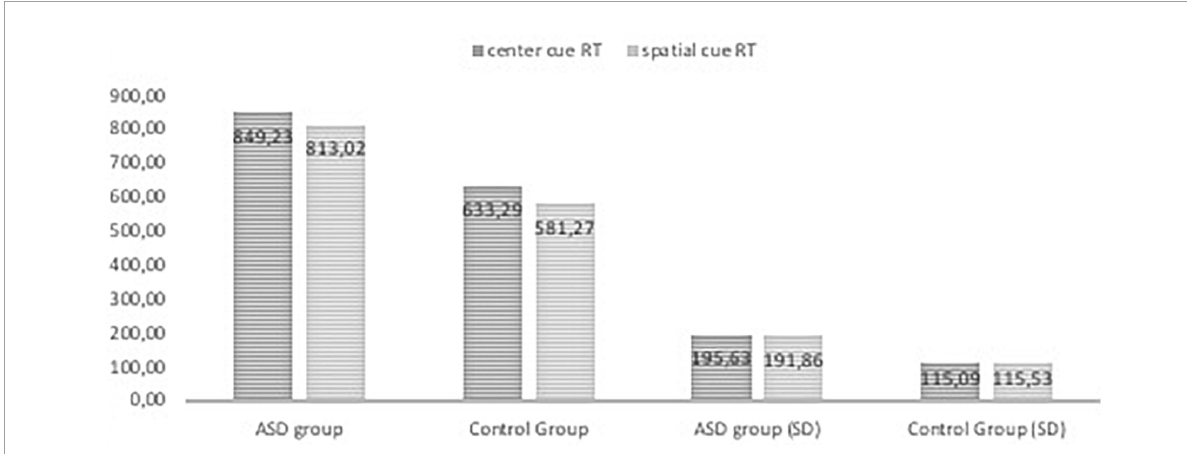
FIGURE3 Reaction time in the ANT tasks with center cue and spatial cue conditions in ASD group and control group.